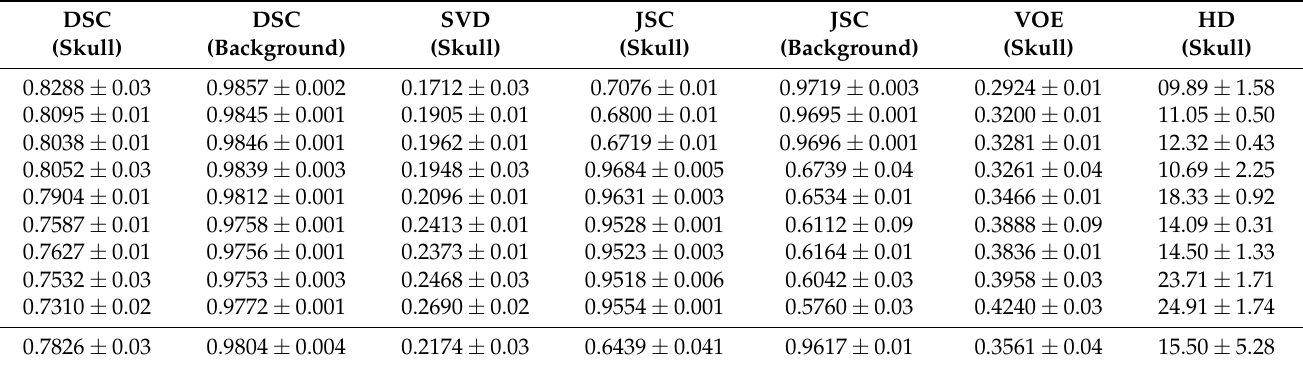
Table 5. Statistical Analysis of the second dataset.